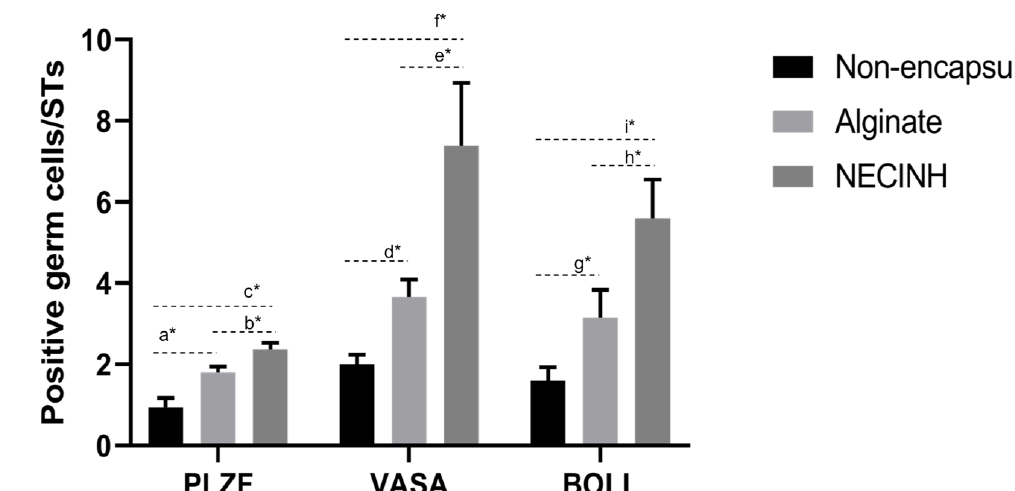
Figure 7. Impact of NECINH-nanoparticles (NPs)-loaded hydrogel on germ cells survival in mice testicular tissue after 21 days of autotransplantation. The number of positive cells/ST section for each